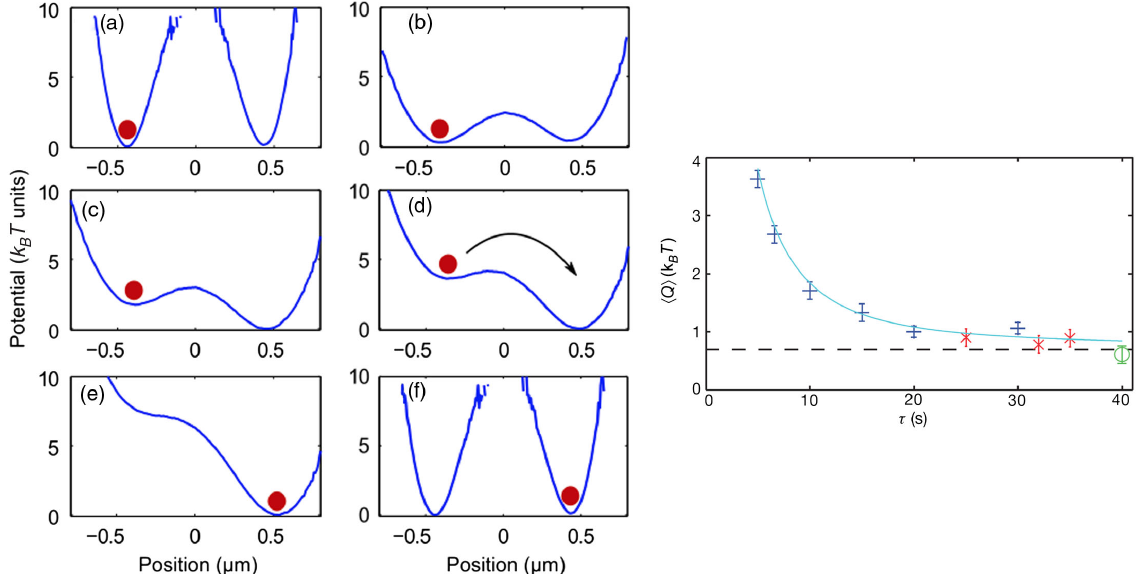
FIG. 16. Experimental verification of Landauer ’ s erasure principle. A colloidal particle is initially confined in one of two wells of a double-well potential with probability one-half. This configuration stores one bit of information. By modulating the height of the barrier and applying a tilt, the particle can be brought to one of the wells with probability one, irrespective of the initial position. This final configuration corresponds to zero bit of information. In the limit of long erasure cycles, the heat dissipated during the erasure process can approach, but not exceed, the Landauer bound indicated by the dashed line in the right panel (see Ref. [150] for